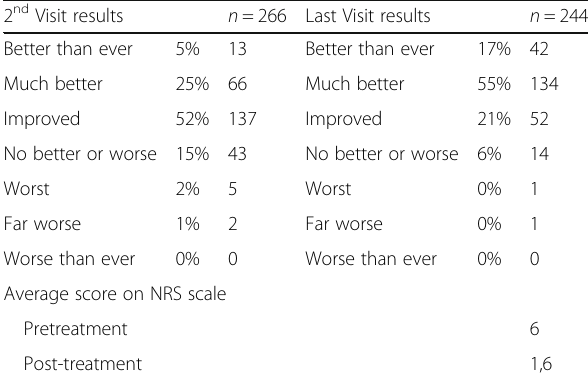
Table 5 Results obtained & NRS scale